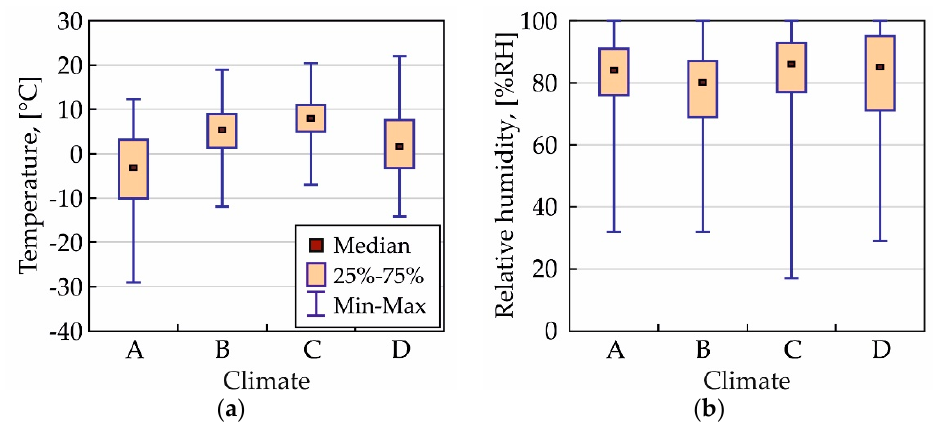
Figure 4. Median, extremes and the 25th and 75th percentile for assumed outdoor climates (A—Greenland, B—Iceland, C—Scotland, D—Norway) for temperature ( a ) and for relative humidity ( b ).